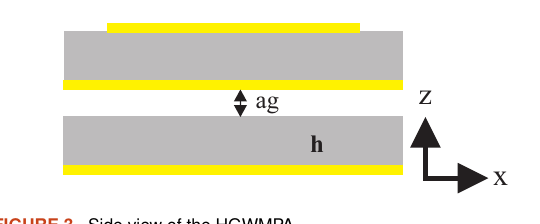
FIGURE 2. Ground plane of the HGWMPA.